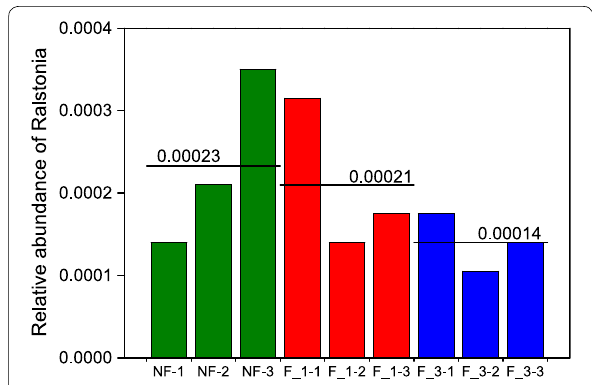
Fig. 3 The relative abundance of genus Ralstonia in different fumiga- tion years. The solid line represents the average. NF non-fumigation,